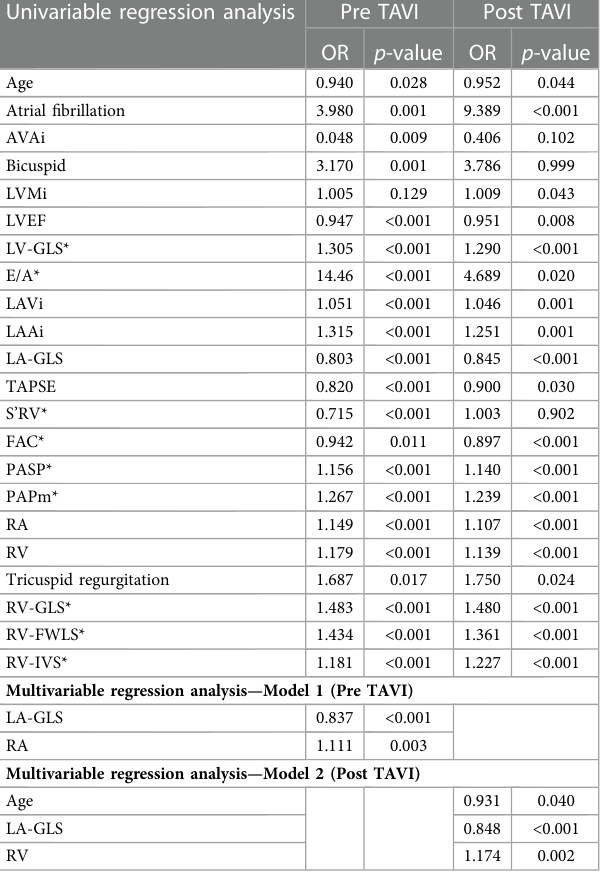
TABLE 5 Univariable and multivariable predictors of RV-PA coupling impairment (binary logistic regression). Univariable regression analysis